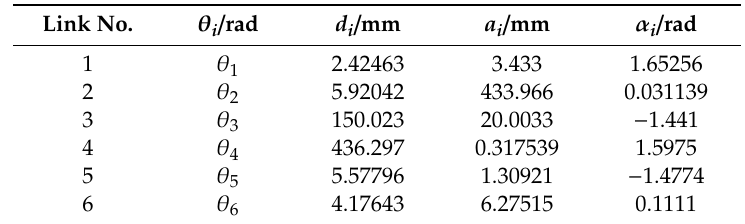
Table 2. DH parameters of the error model.